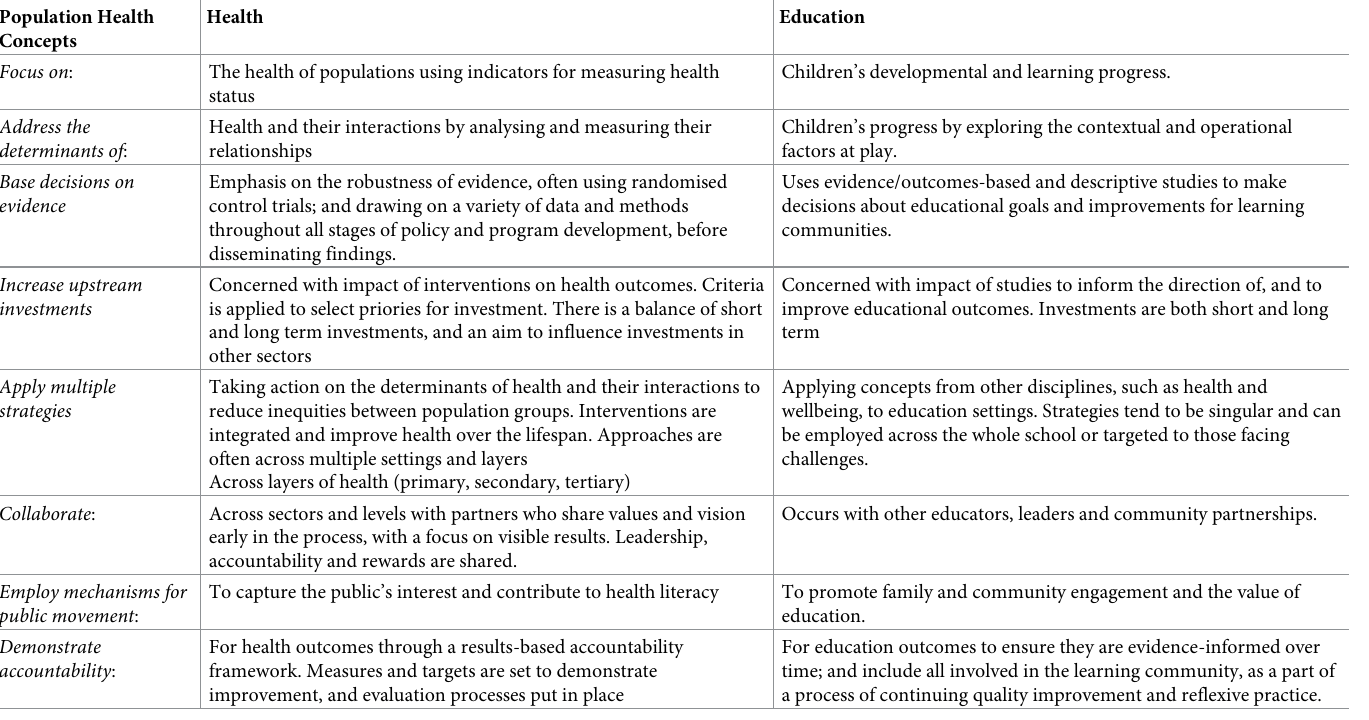
Table 1. Alignment between population health approach elements, in health and education. Population Health